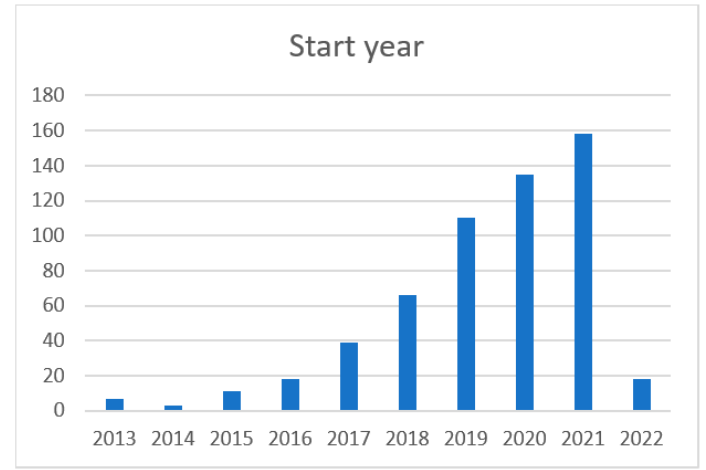
Figure 4. Starting year. Figure 4. Starting